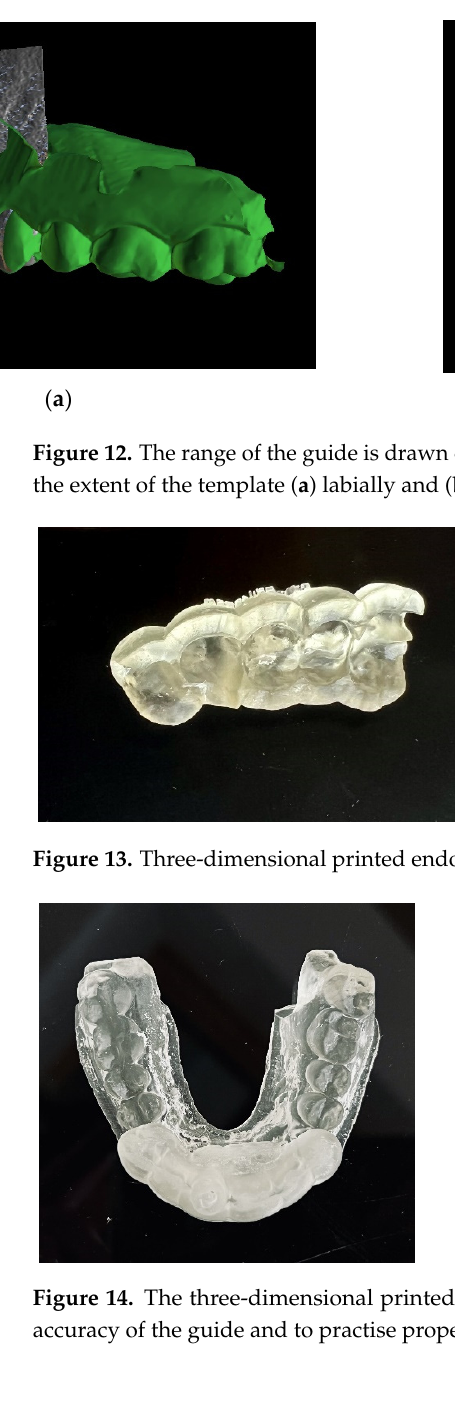
( c ) Figure 15. Radiographic examination was used to confirm ( a ) correct path of access pathway during procedure and ( b ) correct root canal access; ( c ) post-obturation radiograph.